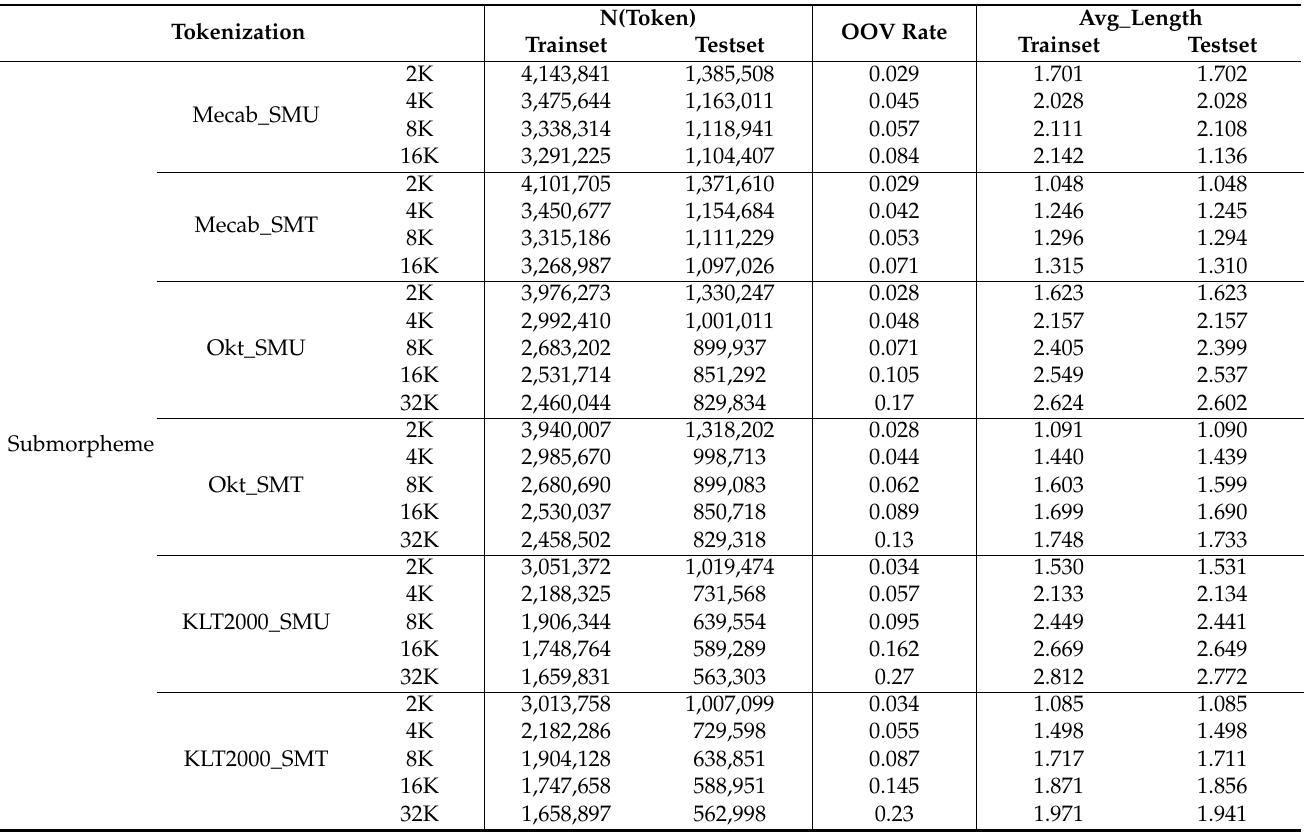
Table A1. Data Distribution for Submorpheme Tokenization in